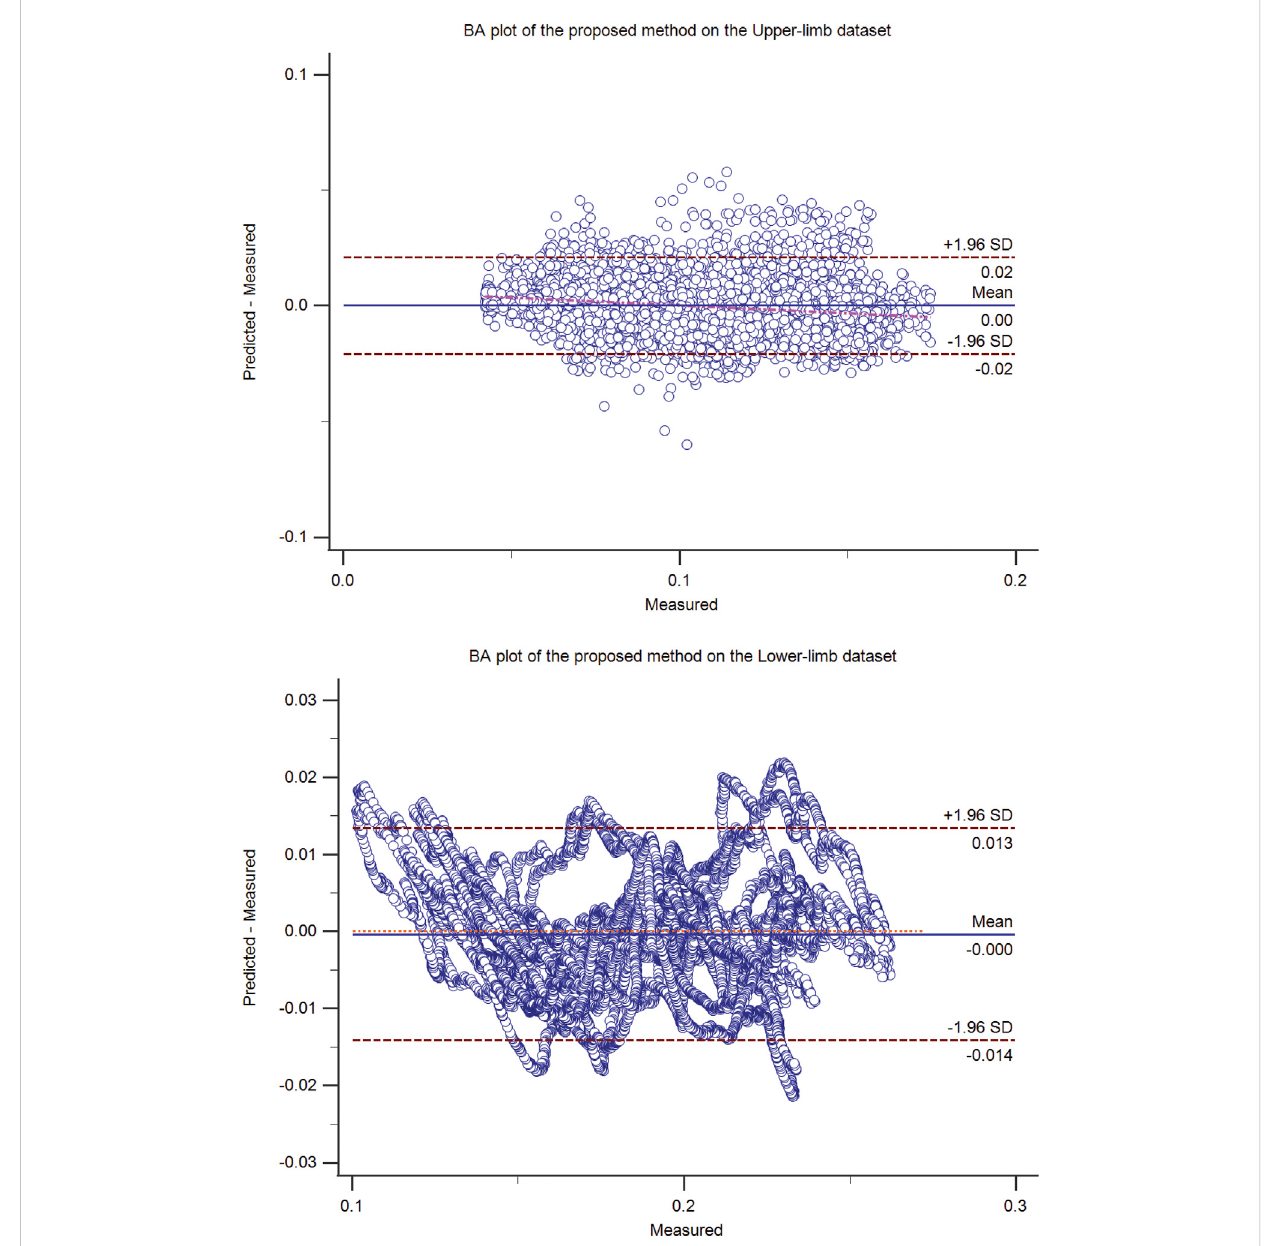
FIGURE 4 TheBland-Altman(BA)plotoftheproposedmethodontheupper-limb(top)andthelower-limb(bottom)testdataset(50%hold-outvalidation).The BA plot shows the scatter plot of the residual signal (predicted force minus measured force signal) (y-axis) and the measured force signal (x-axis), which identi fi esthe homogeneity ofthe residual signal at different measured signal levels. In addition to themean residual signal (i.e., bias), the upper and lower boundaries (mean (residual signal) ± SD (residual signal)) are also